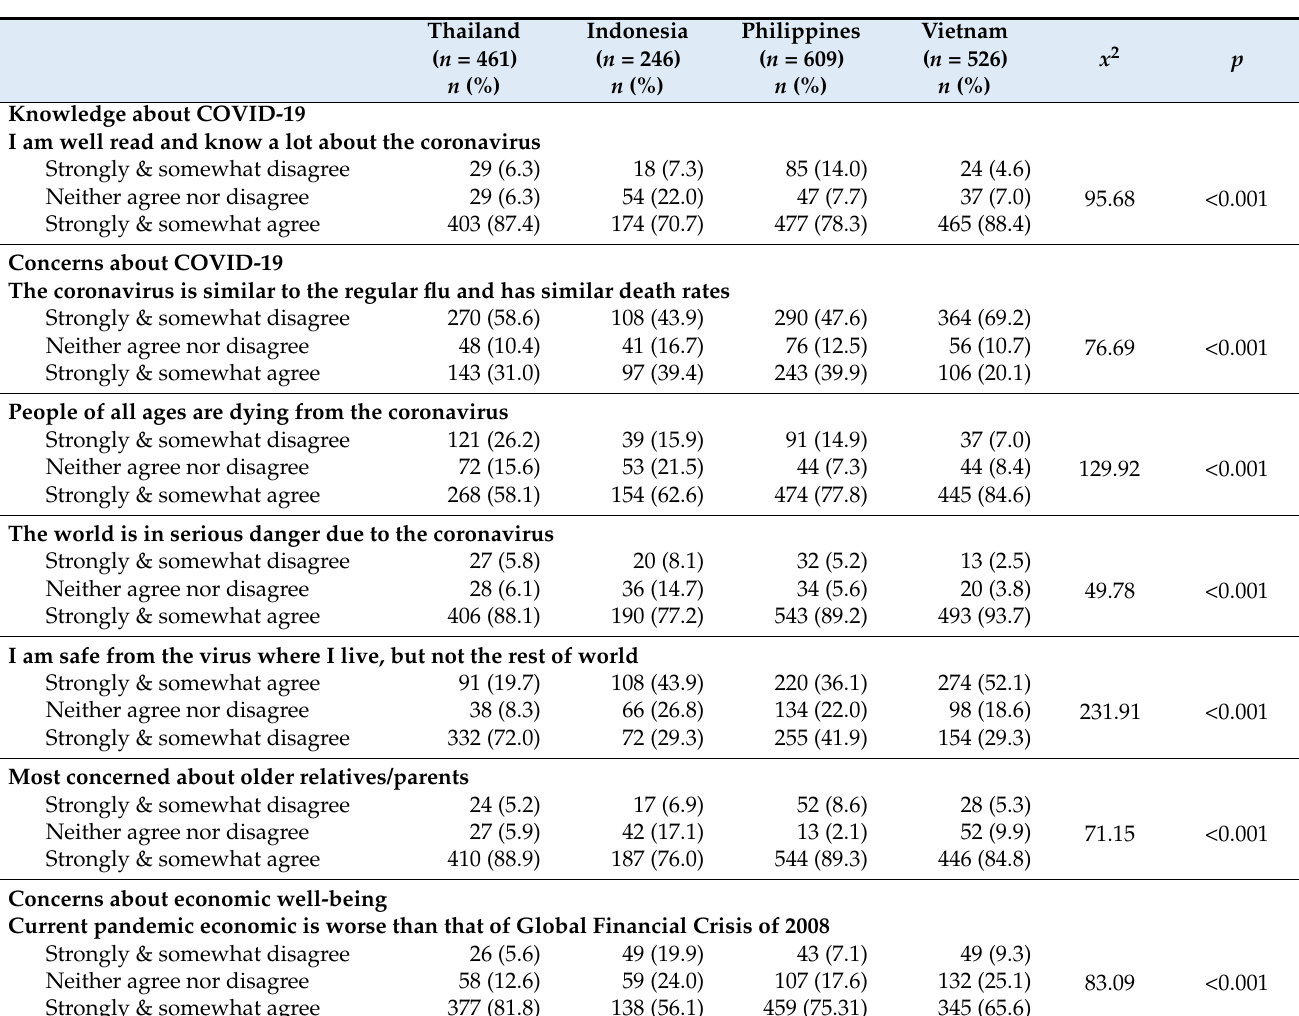
Table 4. Perception about the COVID-19 of the participants not vaccinated yet